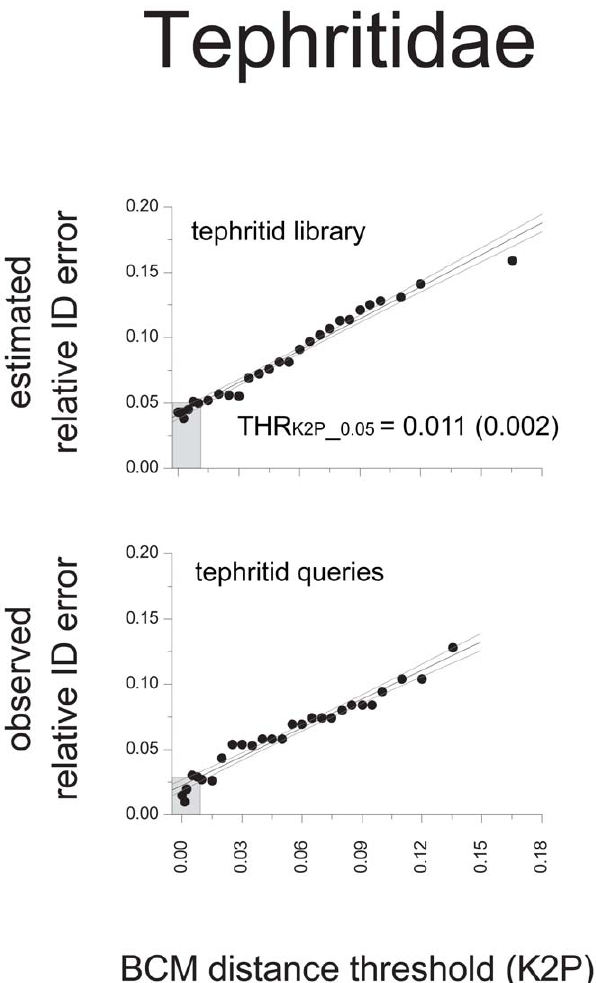
Figure 2. a, b, c: Tephritid Best Close Match (BCM) identification. Proportions of True Positives (TP), False Positives (FP), True Negatives (TN) and False Negatives (FN) at 30 distance thresholds ranging from K2P=0.165 to K2P=0.000. For each distance threshold percentages of queries discarded, accuracy ((TP + TN)/total number of queries) and precision (TP/number of not discarded queries) were calculated.